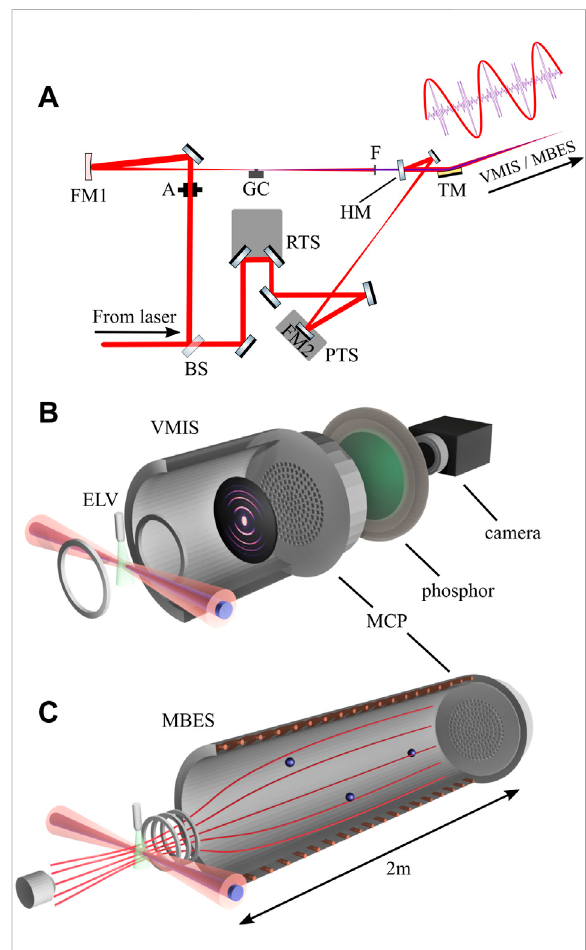
Experimental setup: (A) Optical interferometer allowing us to createanattosecondpulsetrainandadelayeddressing fi eld; (B) Velocity mapimagingspectrometer; (C) Magneticbottleelectronspectrometer. Weusethefollowingabbreviations:BS,beamsplitter;A,aperture; FM, focusing mirror; GC, gas cell; RTS, rough translation stage; PTS, piezo-driven translation stage; HM, holey mirror; F, fi lter; TM, toroidal mirror; ELV, Even-Lavie valve; MCP, microchannel